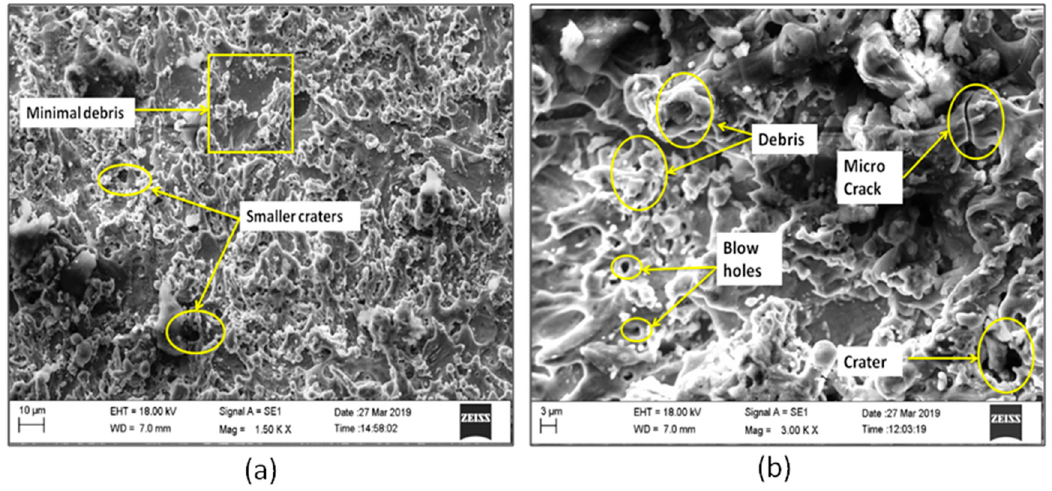
Figure 3. Surface morphology for higher and lower SR: ( a ) scanning electron microscopy (SEM) image for lower SR and ( b ) SEM image for higher SR.